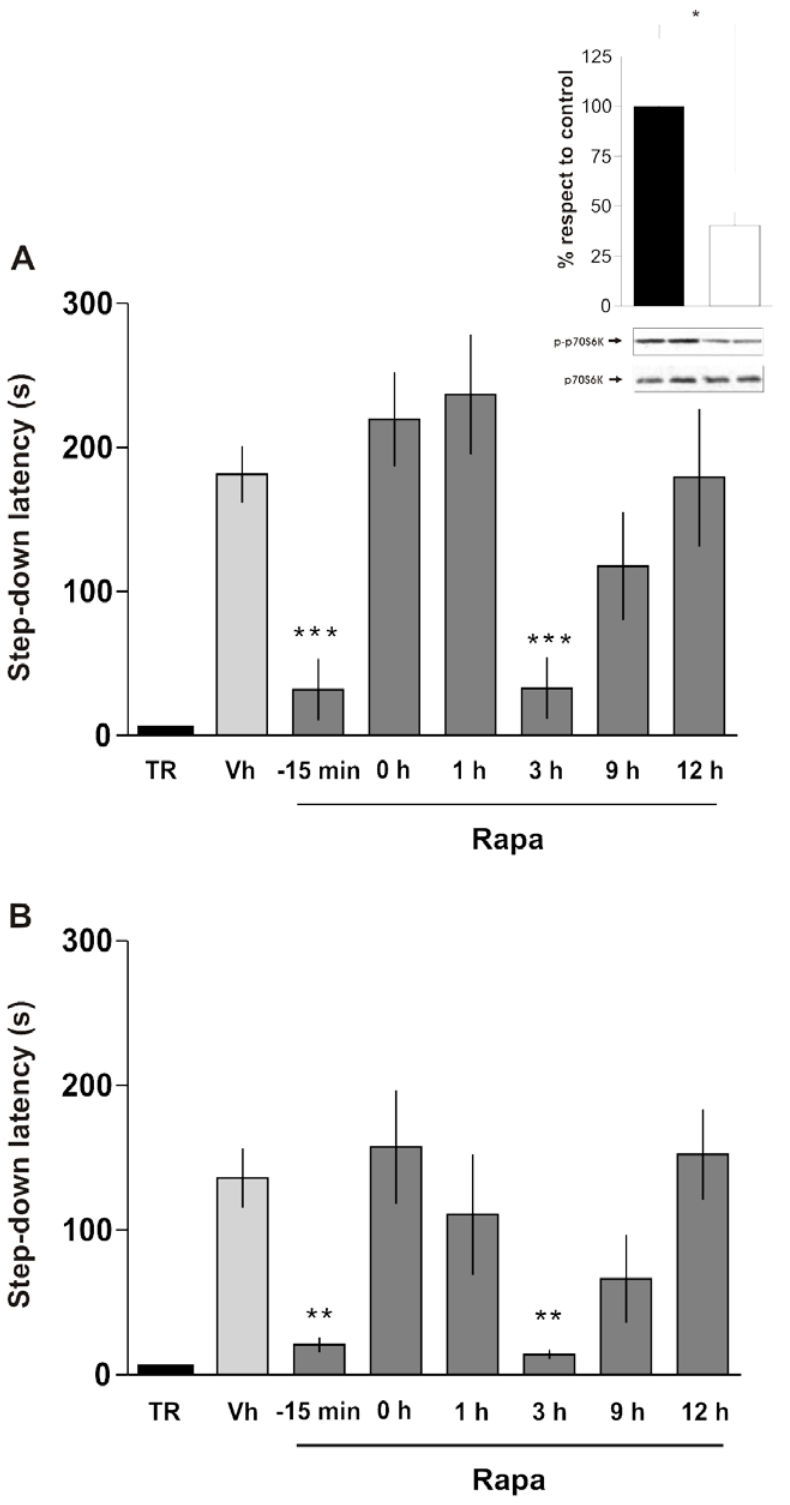
Figure 3. mTOR Signaling Is Required for IA Memory Consolidation During Two Restricted Time Windows After Training. Data are expressed as mean ( 6 SEM) of training (TR, black bars) or test session step-down latency at 24 h (A) or 7 days (B) after IA training. Animals were infused intra-CA1 of the dorsal hippocampus with vehicle (Vh, light grey bars) or rapamycin (4.3 pg/side, dark grey bars), 15 min before or 0, 1, 3, 9, and 12 h after training. Inlet: Rats were infused into the dorsal hippocampus with rapamycin (4.3 pg/side) or vehicle and sacrificed 15 min after drug infusion for analysis of p70S6K activation in the dorsal hippocampus by Western blot. Bars represent the p-p70S6K/p70S6K ratio of rapamycin (white) respect to vehicle (black) treated rats. *p , 0.05, **p , 0.01, ***p , 0.001 vs. Vh for each time point, n=8–10 per group for each experiment in A and B and n=5 per group in the inlet.